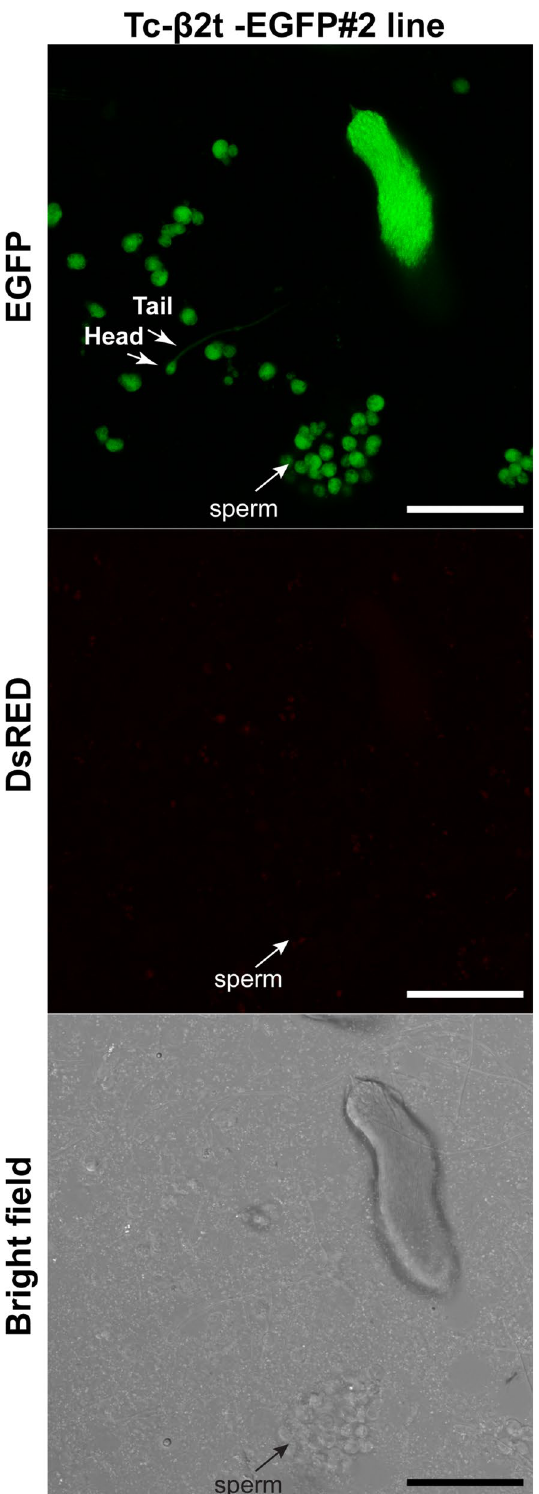
Figure 9. Tc-β2t drives EGFP expression in mature sperm. Sperm from testis of Tc-β 2 t-EGFP#2 viewed under EGFP, DsRED and Bright field filters. Green fluorescence can be visualized among single sperm as indicated by arrows. Scale bar indicates 50